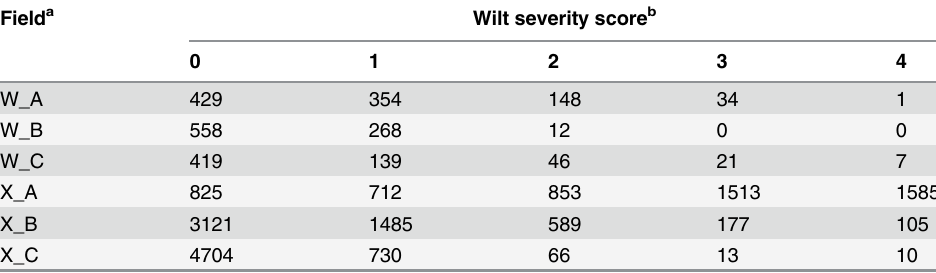
a Three plantations were located in Weinan, Shaanxi (W_A, W_B, W_C) and three in Xinjiang (X_A, X_B, X_C). b Wilt severity on individual plants was recorded on a scale of 0 to 4: 0 — no symptoms; 1 — (cid:2) 25% leaves with wilt symptoms; 2 — leaves with wilt symptoms > 25% and (cid:2) 50%; 3 — leaves with wilt symptoms > 50% and (cid:2) 75%; and 4 — > 75% leaves with wilt